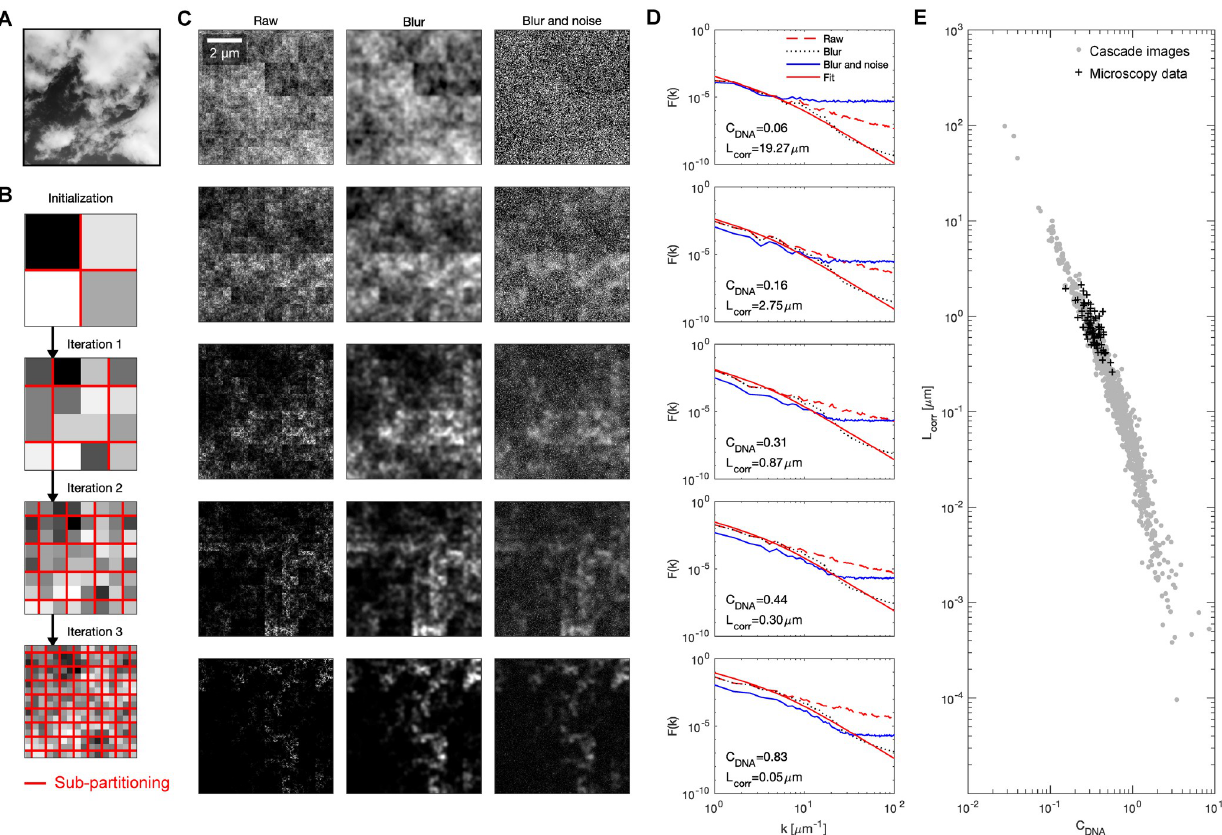
Fig 3. Images generated using multiplicative cascades show similarities with microscopy images of euchromatin. A) Example photograph of a cloud. B) Illustration of the image generation based on multiplicative cascades. In the initial 2-by-2 pixel image, the probabilities P 1 , P 2 , P 3 , P 4 are randomly assigned. During every further iteration, every pixel gets partitioned into four sub-pixels. As part of this sub-partitioning, each pixel is multiplied with one of the probability values P 1 , P 2 , P 3 , P 4 , which are randomly allocated. C) Representative examples of concentration profiles generated by multiplicative cascades. Parameter values P 1 to P 4 used to generate raw distributions of 128-by-128 pixels, from top to bottom: (1, 0.95, 0.9, 0.85), (1, 0.88, 0.76, 0.64), (1, 0.81, 0.62, 0.43), (1, 0.77, 0.54, 0.31), (1, 0.7, 0.4, 0.1). “Blur” images were obtained by smoothing with a two-dimensional Gaussian filter ( σ 1 = 80 nm). “Blur and noise” images were created by further adding Poisson detector noise to every pixel ( λ = 1, no second blurring step). D) Calculation of F ( k ) curves and extraction of L were carried out identically to microscopy data, polynomial fit and L are based on the F ( k ) curves from the Blur images. E) A set of corr corr multiplicative cascades with randomly assigned parameters was executed to allow the comparison of C DNA and L corr values against experimental results.